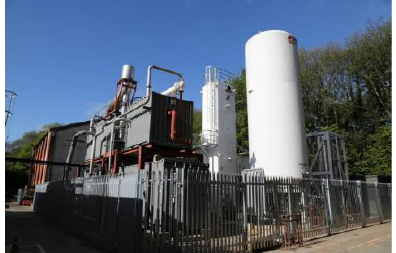
Figure 11. 350 KW/2.5 MWh LAES pilot plant at Birmingham [59].